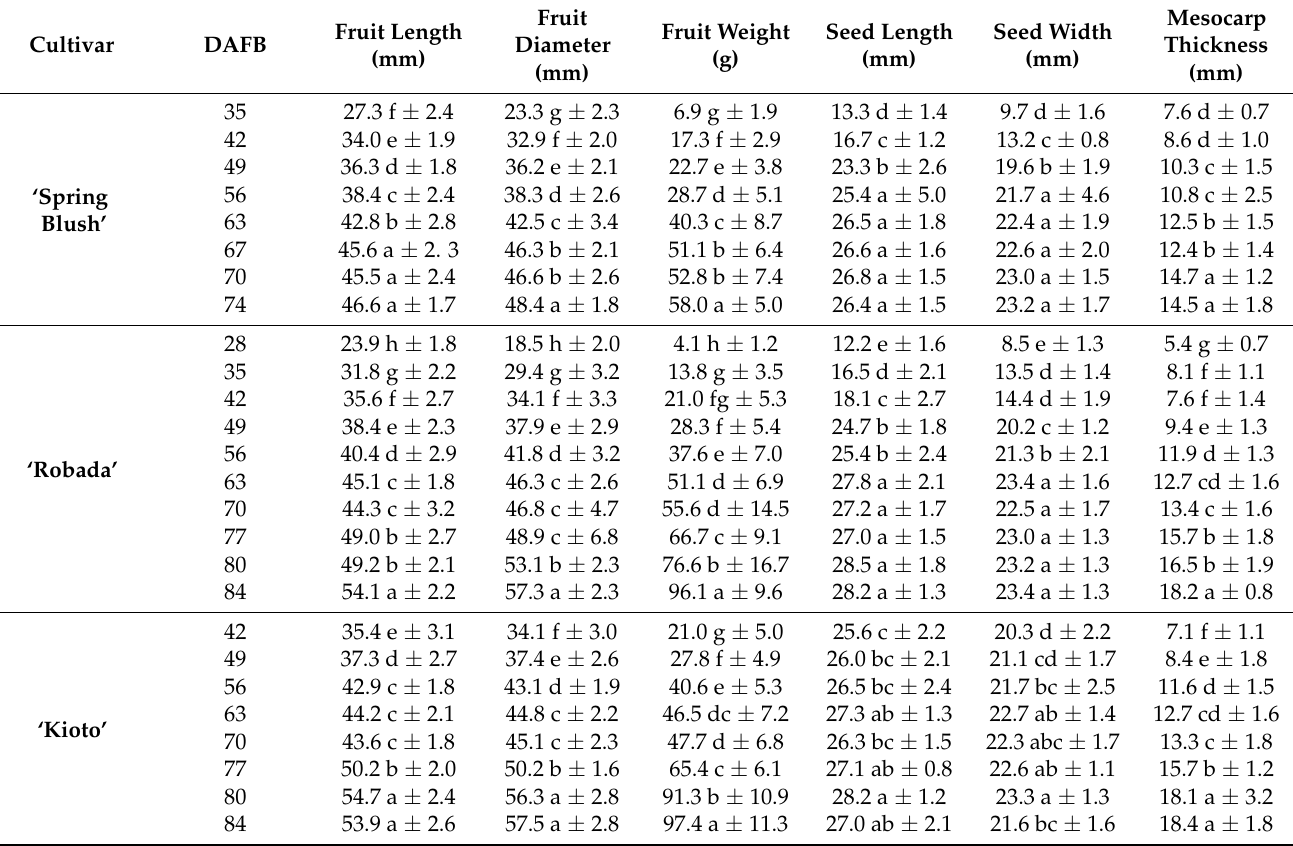
Table 1. Evolution of physical parameters of the apricot cultivars during growth and ripening.